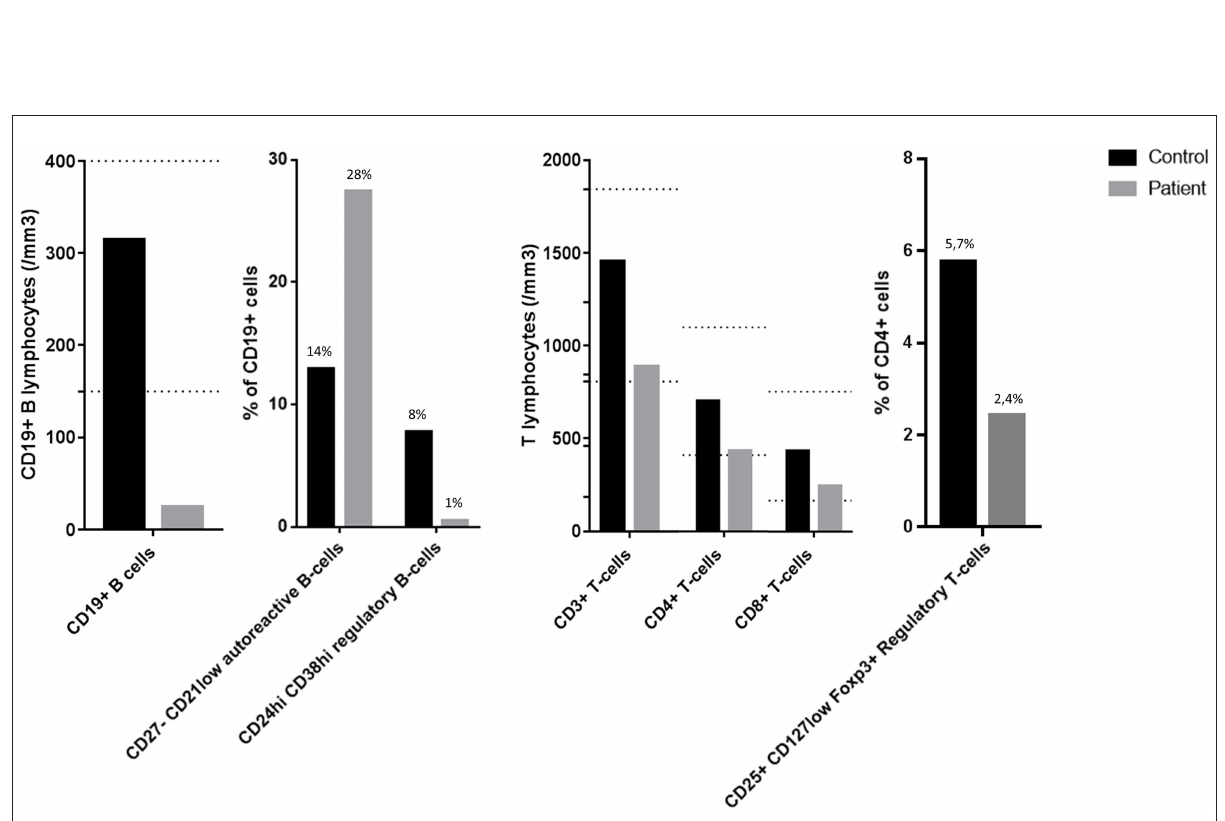
FIGURE2 Flow cytometry analyses of B-cell and T-cell subpopulations. The dotted lines represent the normal range of the laboratory: CD19 + B lymphocytes 169–271/mm 3 ; CD3 + T lymphocytes 807–1844/mm 3 ; CD4 + T lymphocytes 460–1232/mm 3 ; CD8 + T lymphocytes 187–844/mm 3